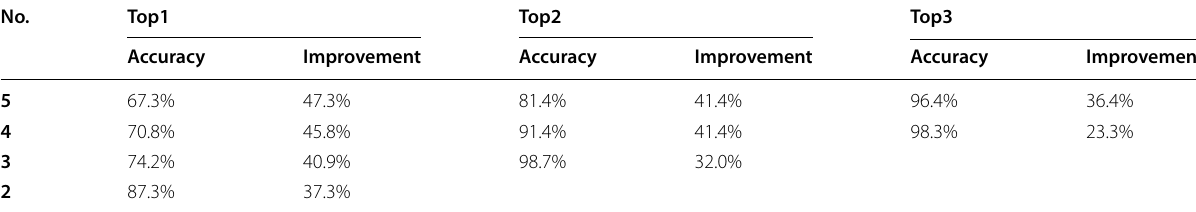
Table 3 Accuracy and Improvement of roadway models with different group numbers No.